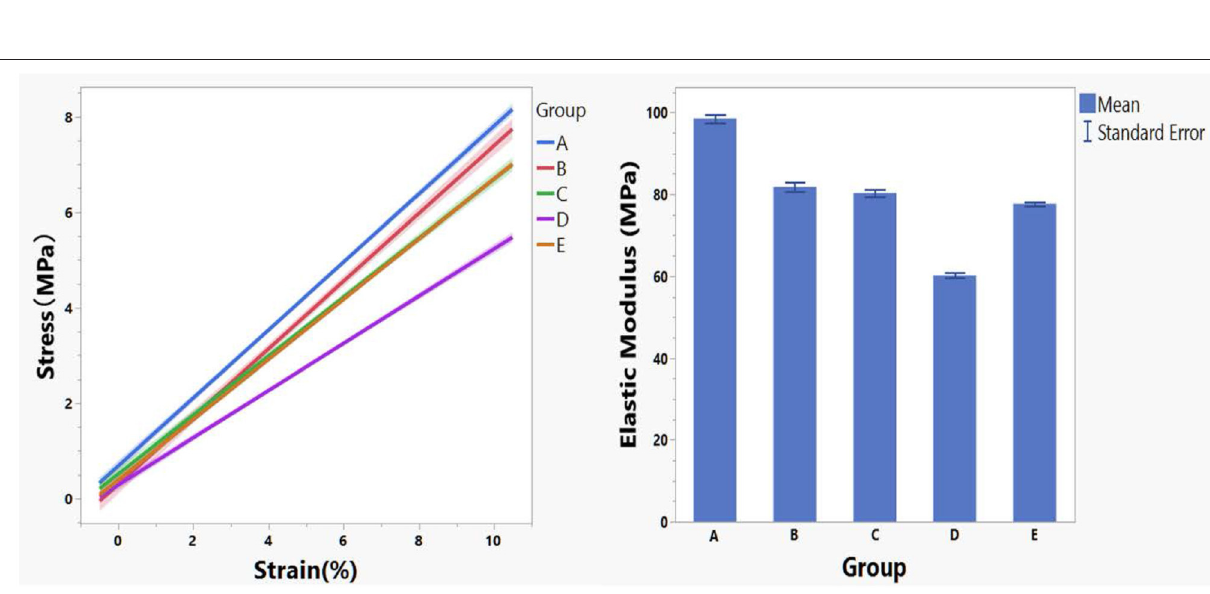
groups: enzymatic solution (six discs) and PBS (four